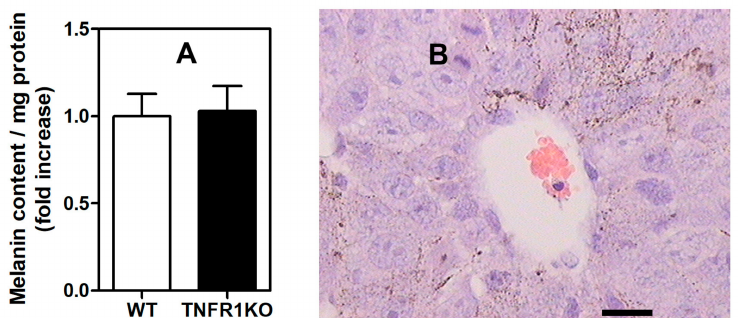
Figure 3. Melanin content is similar in tumors developed in wild type (WT) and TNFR1 KO mice. ( A )Quantificationofcellularmelaninnormalizedtoproteinconcentration.Resultsareshownasthemean ± SEM of 3 independent experiments and are standardized per mg tumor protein. ( B ) Brown-blackish melanin granules typically observed in hematoxylin-eosin (H&E) stained tumor tissue. Scale bar: 25 µ m.